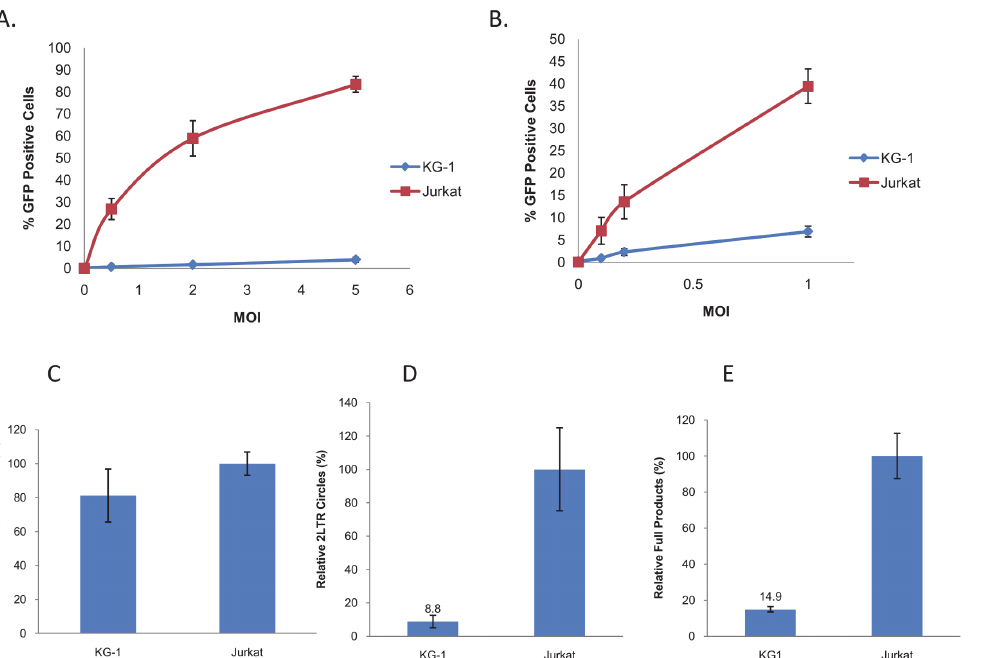
Fig 6. KG-1 cells are refractory to infection with retroviruses pseudotyped with amphotropic envelope. (A) KG-1 and Jurkat cells were infected with 4070A pseudotyped MLV-EGFP at different MOIs. Percentage of EGFP positive cells were determined 3 days post infection. ( B) KG-1 and Jurkat cells were infected with 4070A pseudotyped HIV-GFP at different MOIs. Percentage of EGFP positive cells were determined 3 days post infection. Infection data Data are from 3 independent experiments and error bars represent standard deviations of the mean. (C) KG-1 and Jurkat cells were infected with 4070A pseudotyped HIV-1 at an MOI of 1 and viral cDNA products were quantified using qPCR for first jump products 8 hours post infection (D) for 2LTR circles at 48 hours post infection and (E) for integrated provirus at 6 weeks post infection. Data are from triplicate samples and are representative of three independent experiments. Errors bars represent standard deviations of the mean.